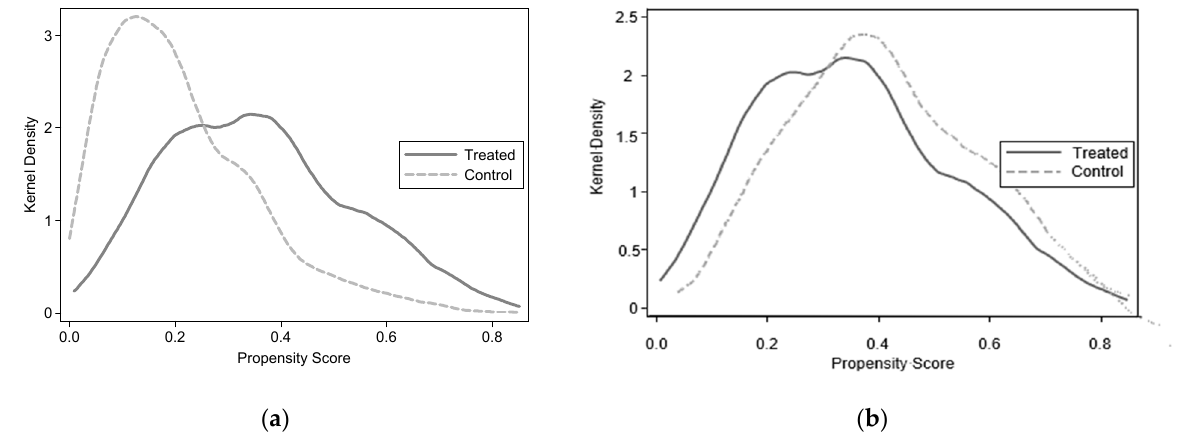
Figure 1. Propensity distribution of the treated and control groups before ( a ) and after ( b ) matching.